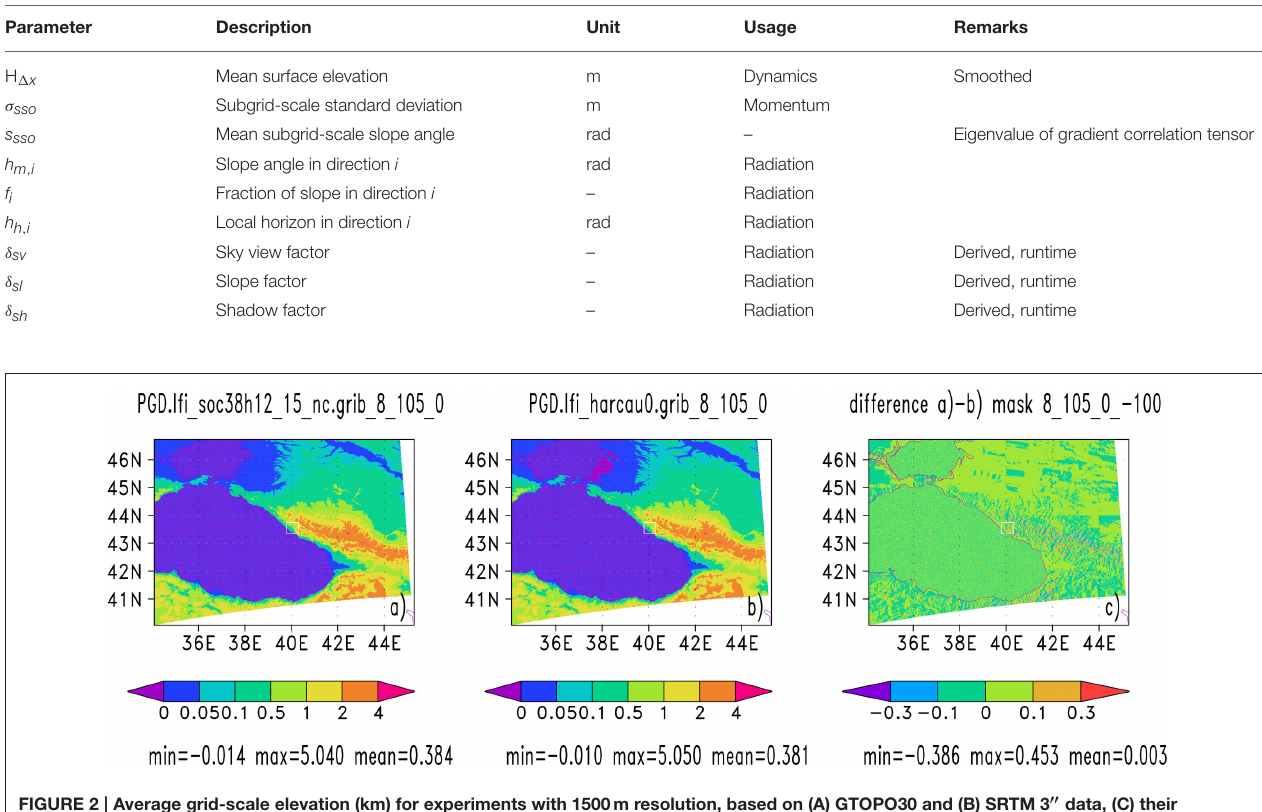
TABLE 1 | Orography-related parameters within grid resolution.